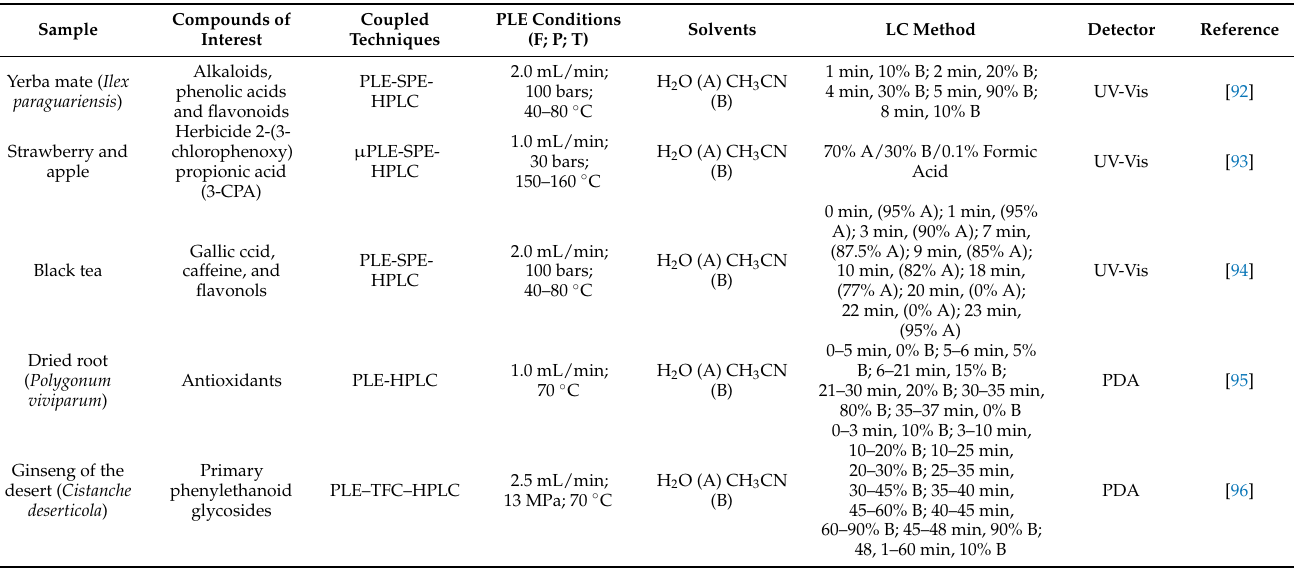
Table 7. Comprehensive report of PLE systems coupled with on-line analysis systems for solid matrices from vegetable